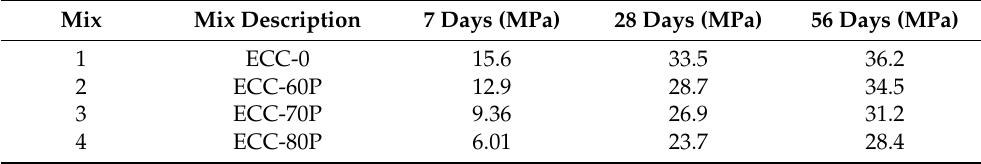
Table 5. Compressive strength for different concrete mixes.